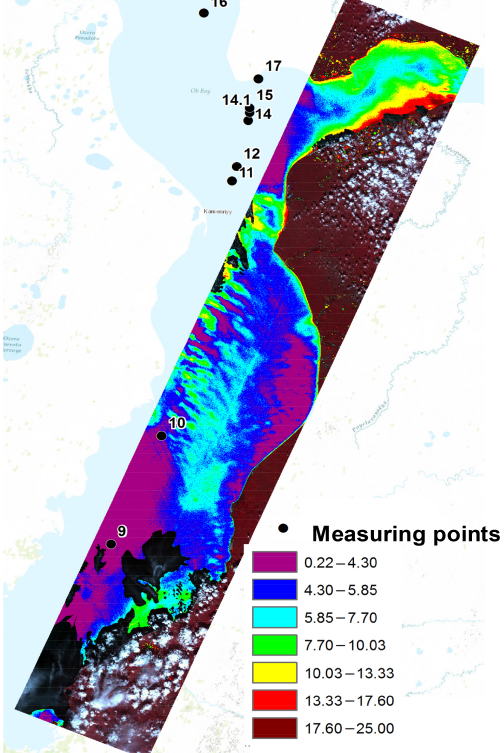
Figure 3. CHL distribution according to Terra/ASTER data, mgm − 3 (16 July